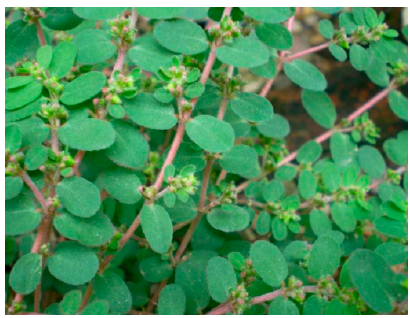
Figure 1. A picture of fresh Euphorbia humifusa